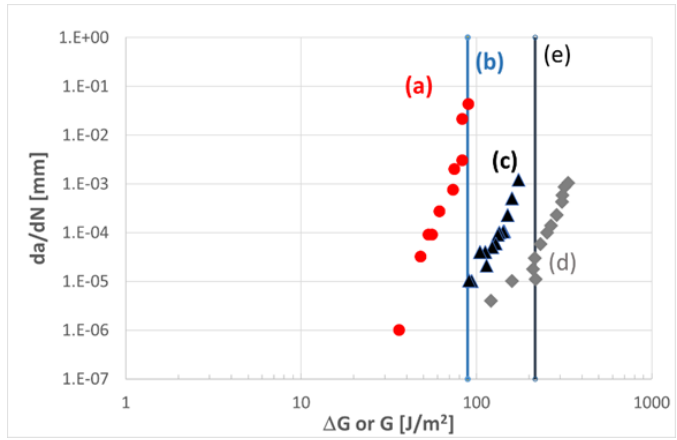
Figure 6. Selected toughness data from the literature: (a) Mode I fatigue fracture of neat RTM6 by Fischer et al. [121], with ΔK converted to ΔG via an average modulus of 3000 MPa ; (b) quasi-static Mode I toughness of neat RTM6 from the Hexflow Product Data Sheet [122]; (c) and (d) two sets from Mode I fatigue fracture of a carbon fibre 5HS weave/RTM6 composite by Yutaka Shiino [123], indicating scatter band and testing; and (e) from quasi-static Mode I testing of CFRP RTM6-2 by Wu et al. [124].